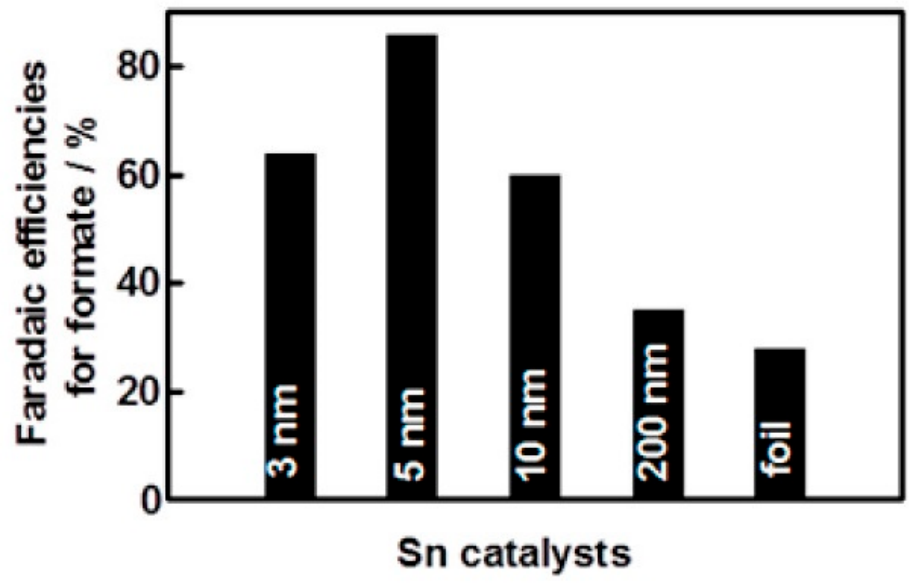
Figure 5. Particle size dependence of faradaic efficiencies for CO 2 reduction to formate on Sn catalysts. Reprinted (adapted) with permission from [20]. Copyright 2014, American Chemical Society.